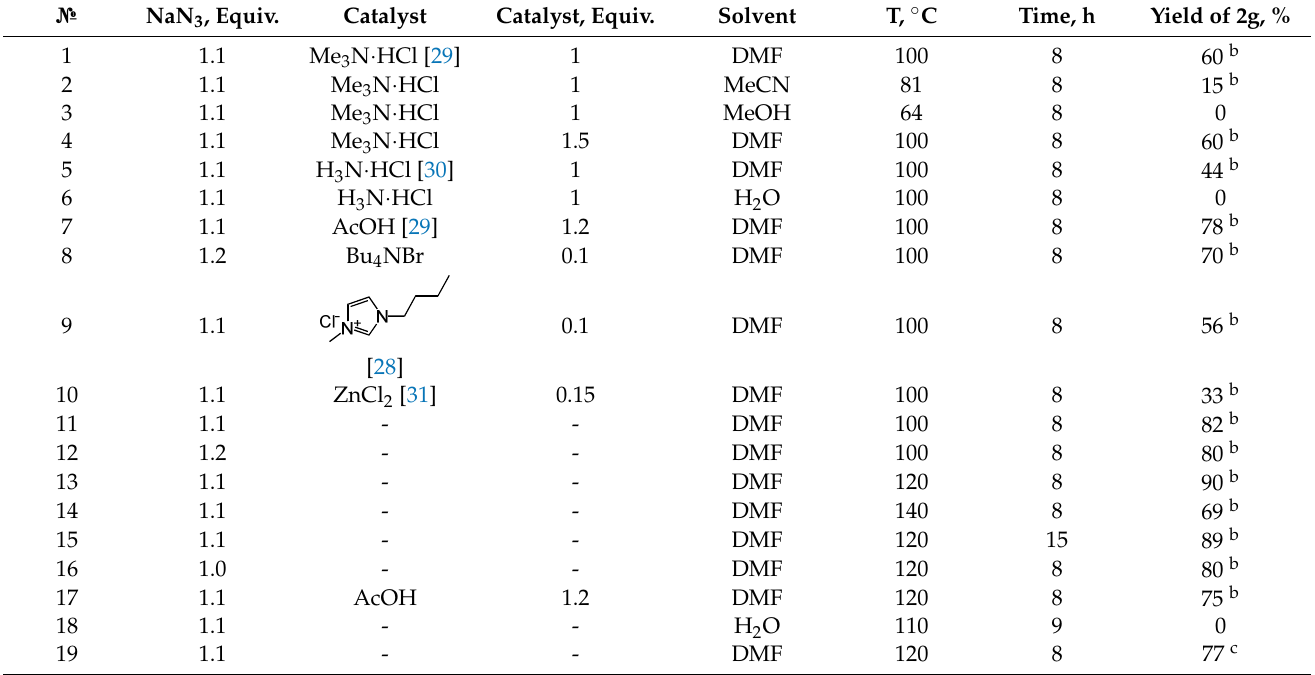
Table 1. Optimization of reaction parameters in the synthesis of tetrazolyl-pyrazolopyrimidine 2g a . Catalyst, NaN 3 , Solvent Т , ° С Time, h Yield of 2g, % Catalyst № Equiv. Equiv.